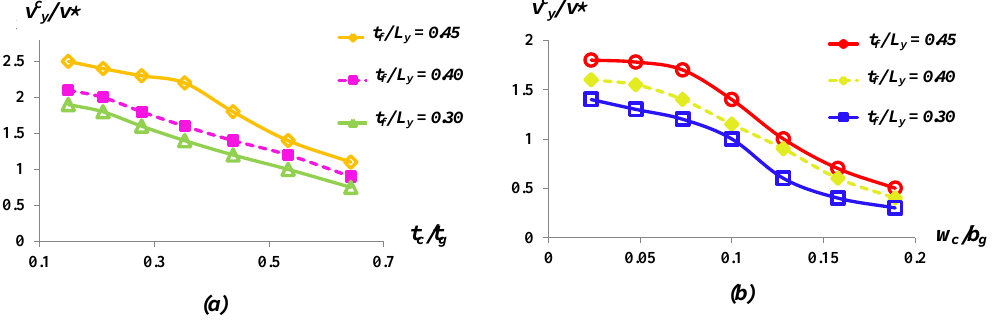
Figure 7. Variation of v c y / v ∗ as a function of ( a ) t c / t g in the range 0.2 (cid:54) t c / t g (cid:54) 0.68 and ( b ) w c / b g in the range 0.03 (cid:54) w c / b g (cid:54) 0.2 for different values of t f / L y